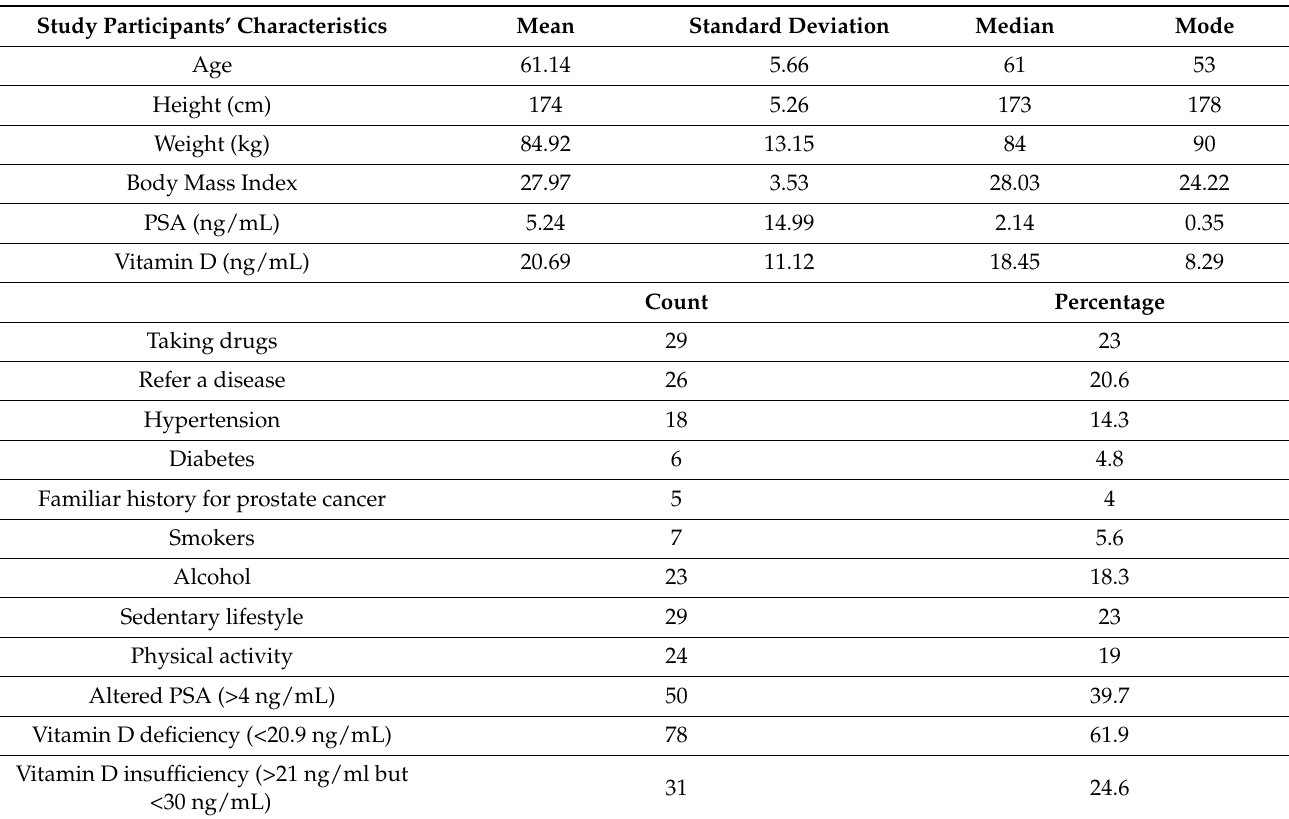
Table 1. Descriptive characteristics of patients enrolled.